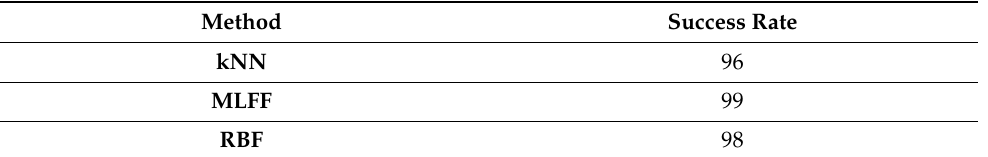
Table 4. Success rate for the different pattern recognition techniques for the online experiments. Units in